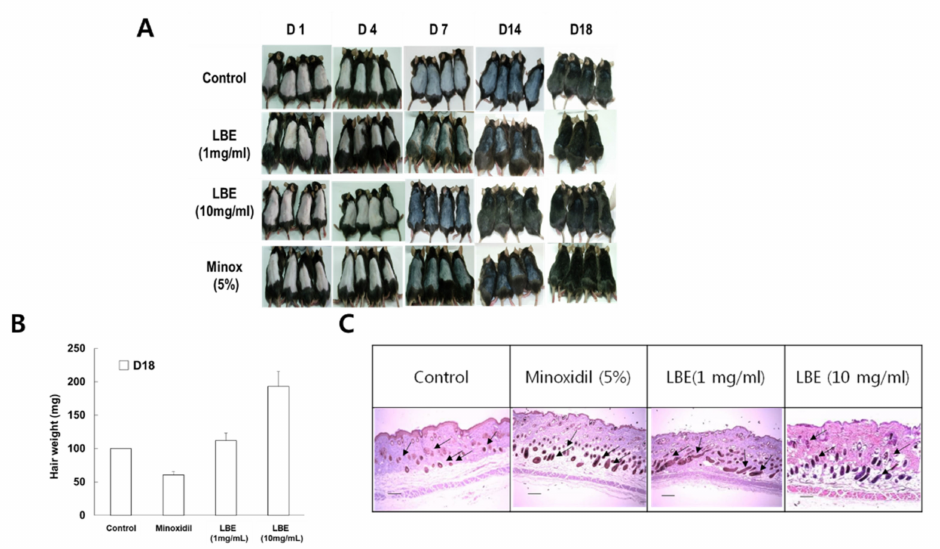
Figure 3. Hair generative effects of LBE in vivo. ( A ) After depilation, photos were taken on the 1, 4, 7, 14, and 18th days. Skin darkness turned gray earlier in the LBE treatment group than in the control group; ( B ) hair weight; ( C ) effects of LBE on anagen phase extension in C57BL/6 mice. The back skin tissue of C57BL/6 mice was separated 18 days after depilation and stained with hematoxylin & eosin. Representative histology from four animals is shown. Compared with the control (vehicle and positive) groups, the LBE groups had greater hair follicle growth from the subcutaneous to the epidermis. Scale bars = 0.5 µ